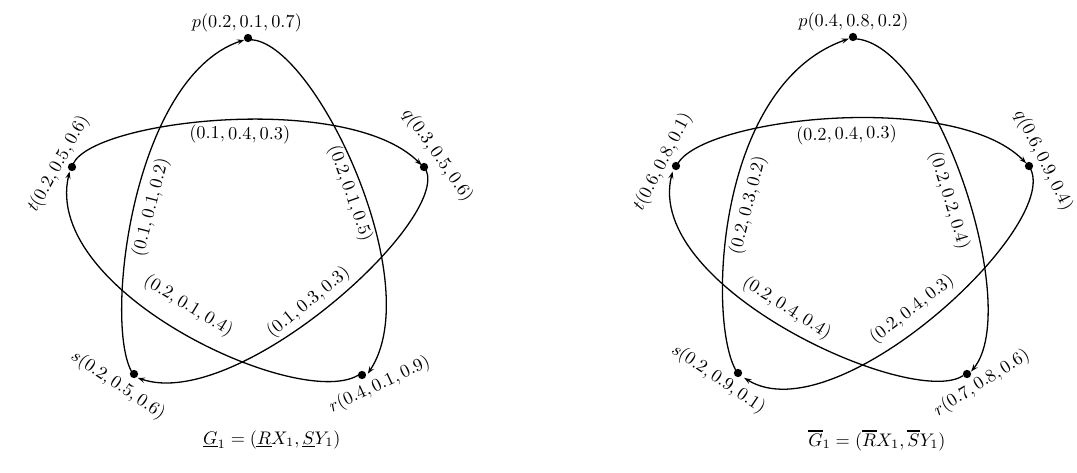
, G 1 ) Figure 1. Neutrosophic rough digraph G 1 1 = ( G 1 , G 1 )